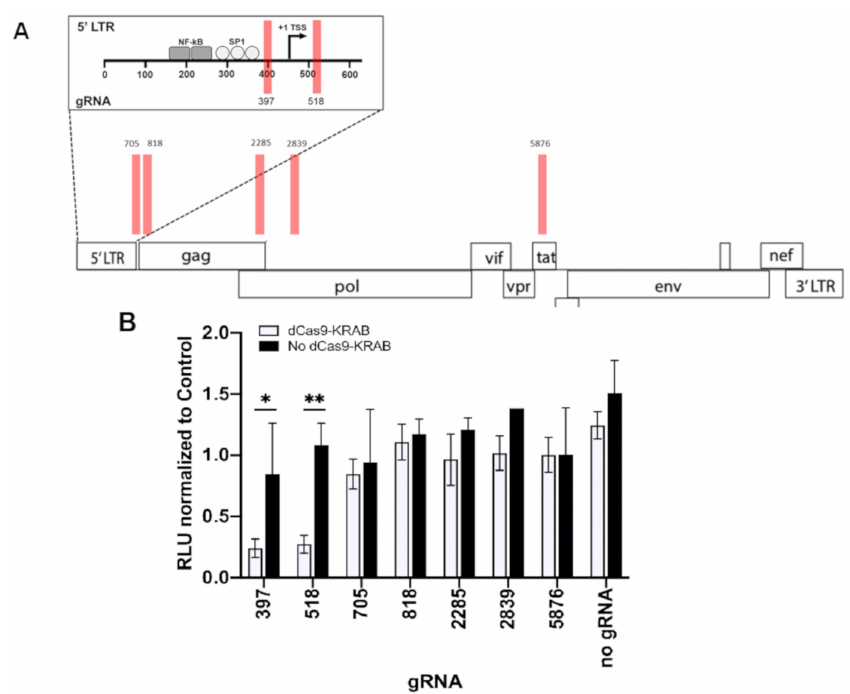
Figure 1. Identification of HIV-1 guide RNAs (gRNAs) that mediate disabled Cas9 (dCas9)- Kruppel-associated box (KRAB) repression. ( A ) Cartoon demonstrating locations targeted by gRNAs. ( B ) Repression of HIV transcription by gRNAs. HEK293T cells were cotransfected with NL4-3- ∆ env -Luciferase, dCas9-KRAB, and the indicated guide RNAs. Negative controls included transfections with gRNAs only (black bars). HIV expression was monitored after 48 h by luciferase activity, which was normalized to control gRNA. Data represent averages of multiple experiments, with each guide being assessed in at least three independent experiments. Error bars represent standard error and Student t -test were performed to determine significance. * and ** indicate p ≤ 0.05 and p ≤ 0.01, respectively.